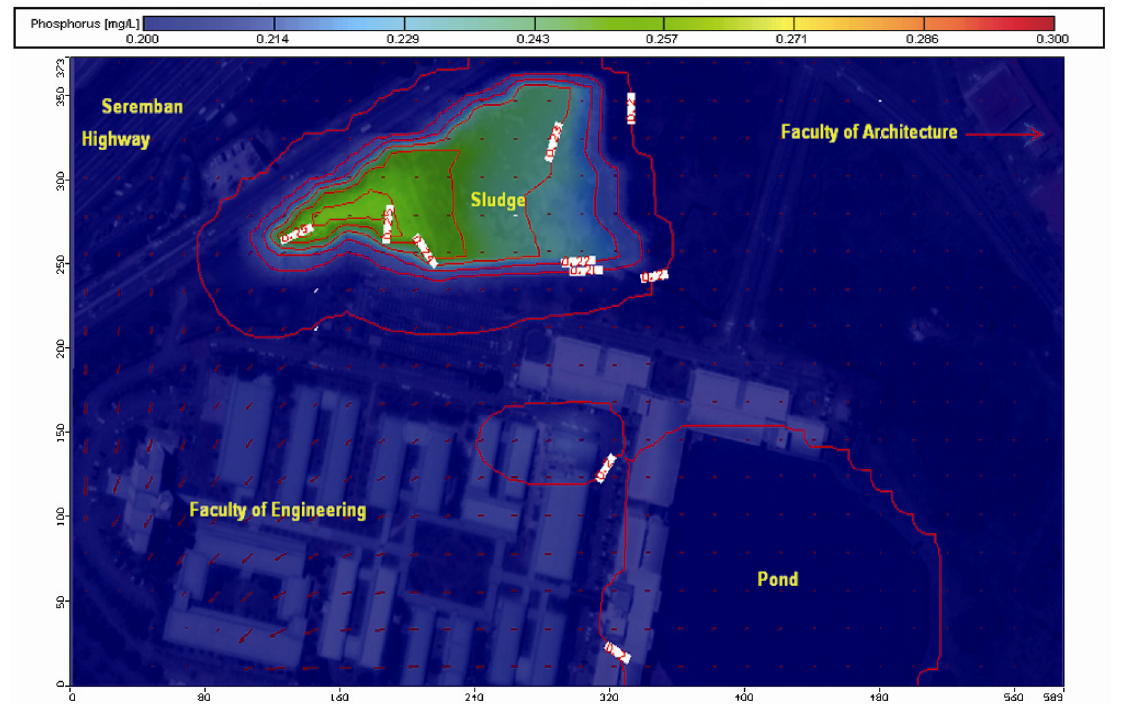
Fig. 4. Result of simulation of contamination migration in Layer No. 2 after 10